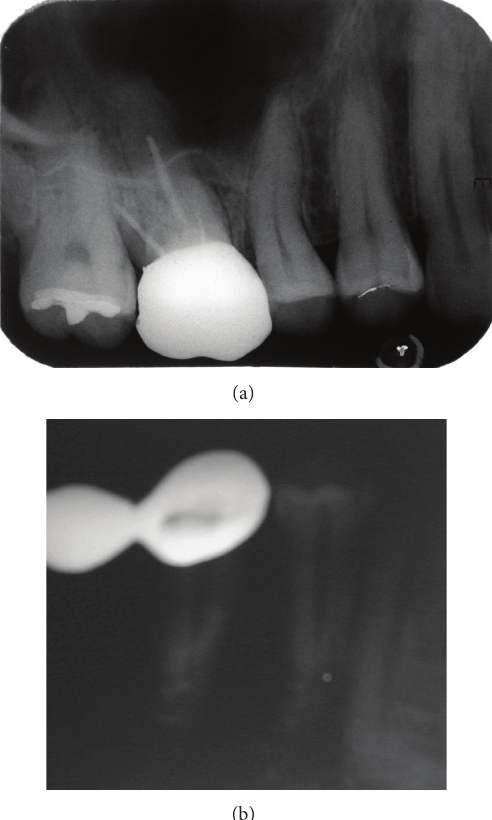
Figure 3: (a) Photograph of intraoral periapical radiograph of 14 showing normal root morphology. (b) Photograph of intraoral periapical radiograph of 44 showing normal root